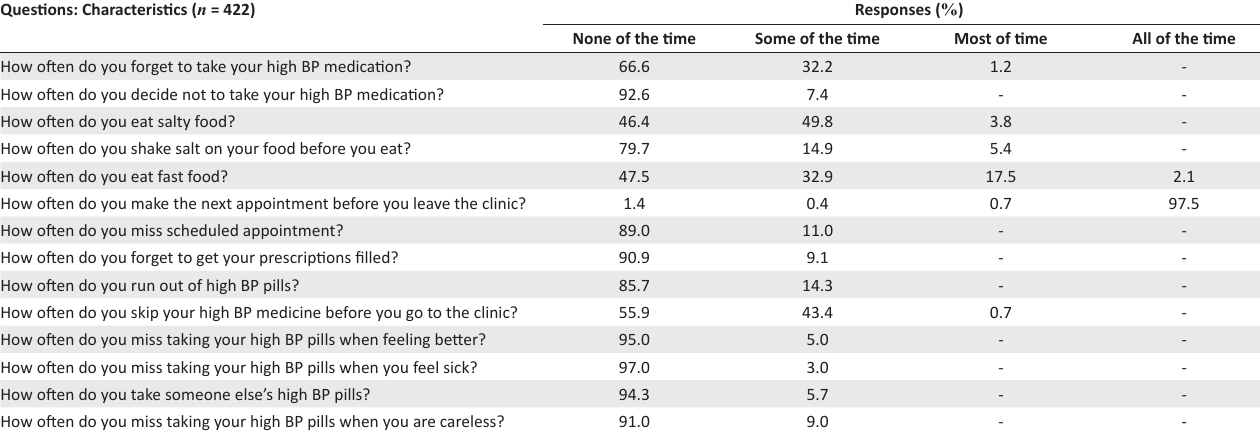
TABLE 1-A1: Questions and responses to the Hill-Bone compliance (adherence) scale. Questions: Characteristics ( n = 422) Responses ( % ) None of the